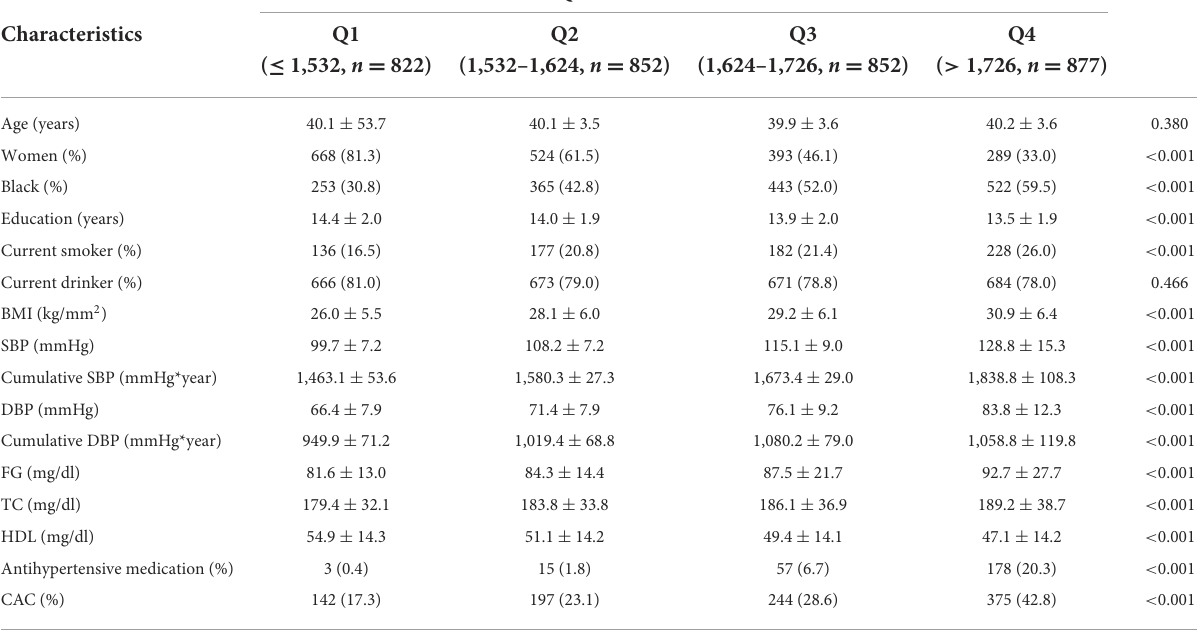
TABLE 1 Baseline characteristics according to cumulative systolic blood